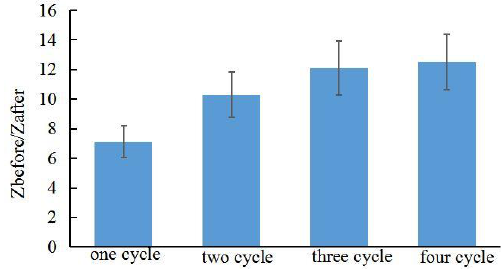
Figure 11. Effect of electroporation (electric field strength = 40 V/cm 2 ; pulse width = 10 ms; number of pulses per second = 10, duration 5 min) and reverse iontophoresis (symmetrical biphasic dc; current density = 0.1 mA/cm 2 ; reversed every 3 min during the 12 min) on the ratio of pre-experimental to post-experimental skin impedance at various times after the promotion penetration experiment.